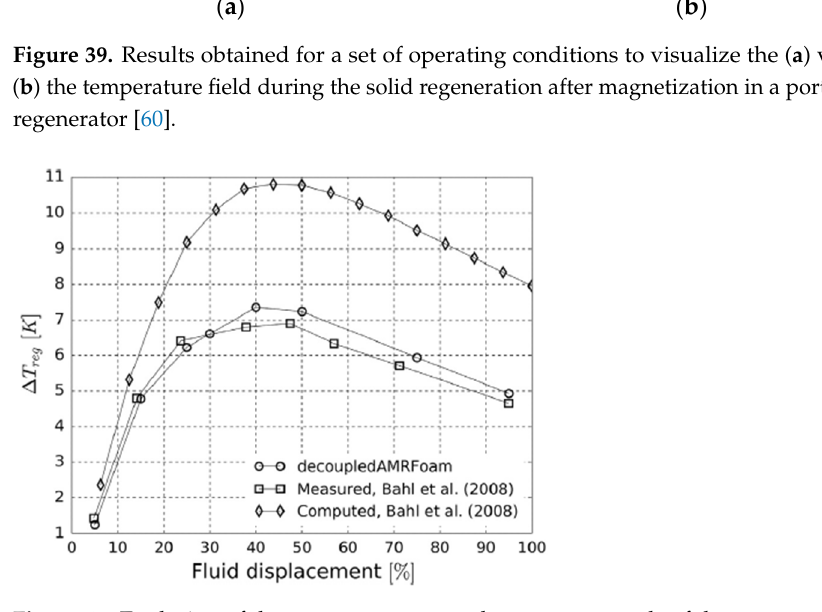
Figure 40. Evolution of the temperature range between two ends of the regenerator as function of the dimensionless fluid displacement. Comparison between the model of Mugica et al. [89] and the model of Bahl et al. [122].